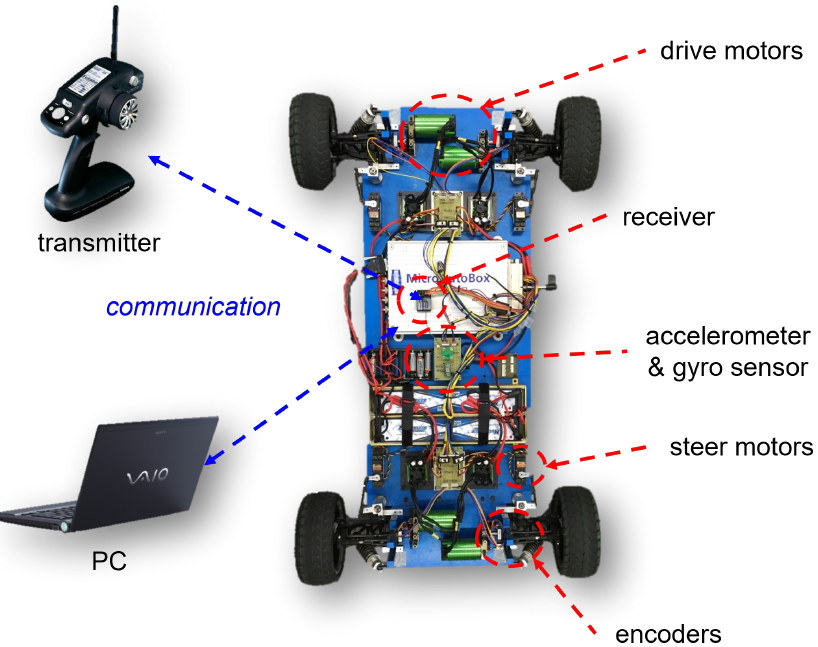
Figure 3. Scaled-down overactuated vehicle